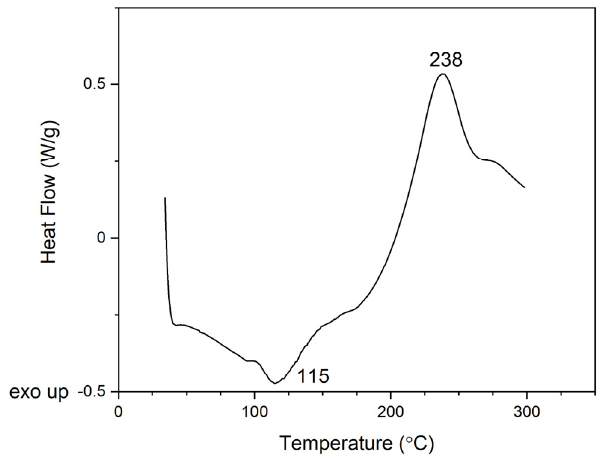
Figure 5. DSC thermogram of BAF-oda-fu.